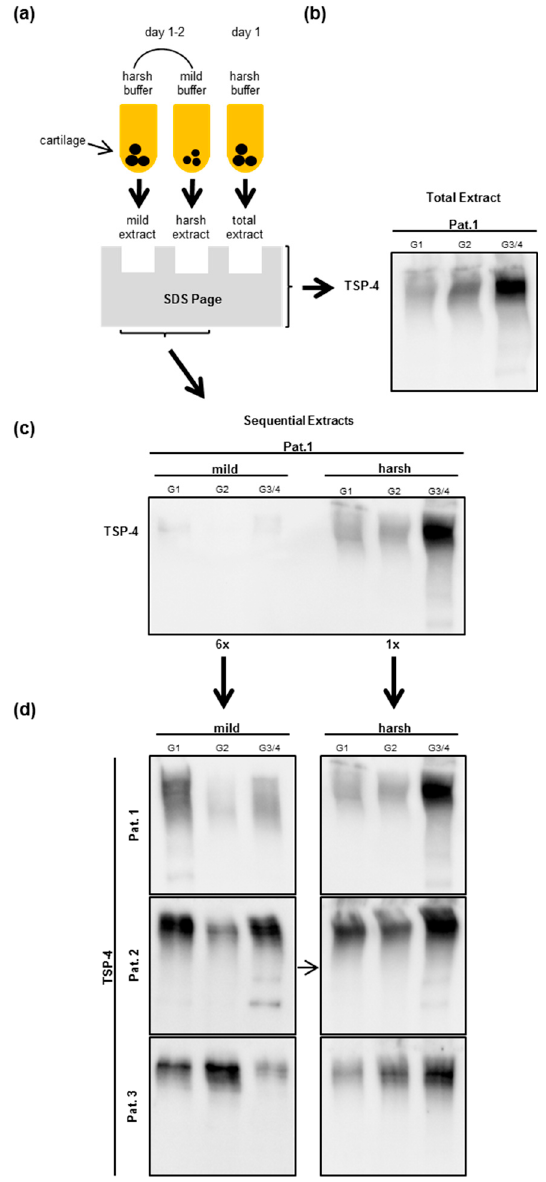
Figure 3. Detection of TSP-4 in extracts after sequential protein extraction from OA knee articular cartilage. ( a ) Schematic overview of the sequential protein extraction procedure. On the first day, proteins were extracted overnight with a mild buffer and supernatants were collected on the following day. Remaining cartilage pieces were resuspended in a harsh buffer to extract still-anchored proteins. To extract total proteins, only the harsh buffer was added and the total protein extract collected. Total ( b ), weakly, and tightly anchored TSP-4 ( c ) level in OA patients were analyzed via immunoblot. When equal protein amounts were loaded, the weakly anchored proteins were hardly detectable. Therefore, a six-fold amount of this extract was loaded to be able to detect differences between OA severity grades and to compare the extraction behavior with that of tightly anchored proteins ( d ). Immunoblots were shown as representative data from different donors. OA severity grades: grade 1 (G1), grade 2 (G2), and grade 3/4 (G3/4). Pat. = patient.